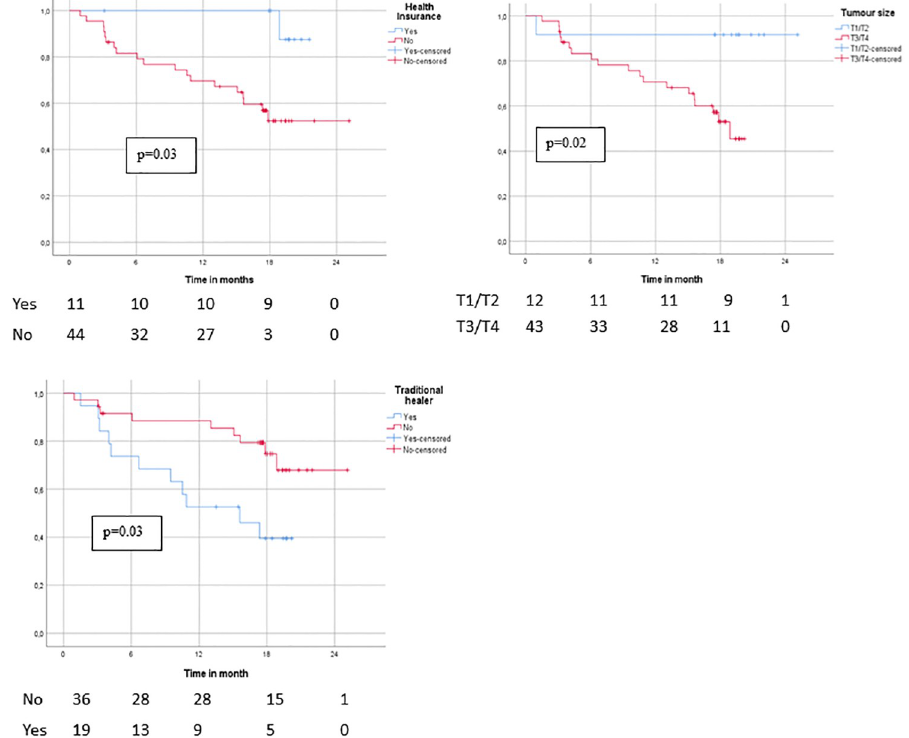
Fig 2. Kaplan-Meier overall survival curves and log-rank tests for health insurance status (yes/no), use of traditional healer (yes/no) and tumour size (T1/T2 and T3/T4).